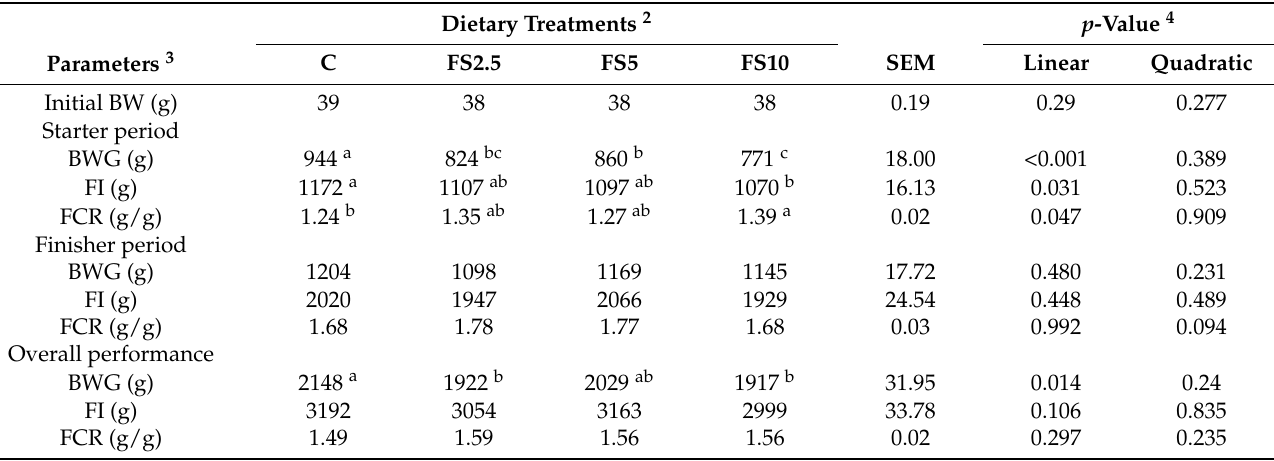
Table 3. Effect of the dietary fenugreek seed (FS) inclusion on the growth performance of straight-run broiler chickens in Experiment 1 1